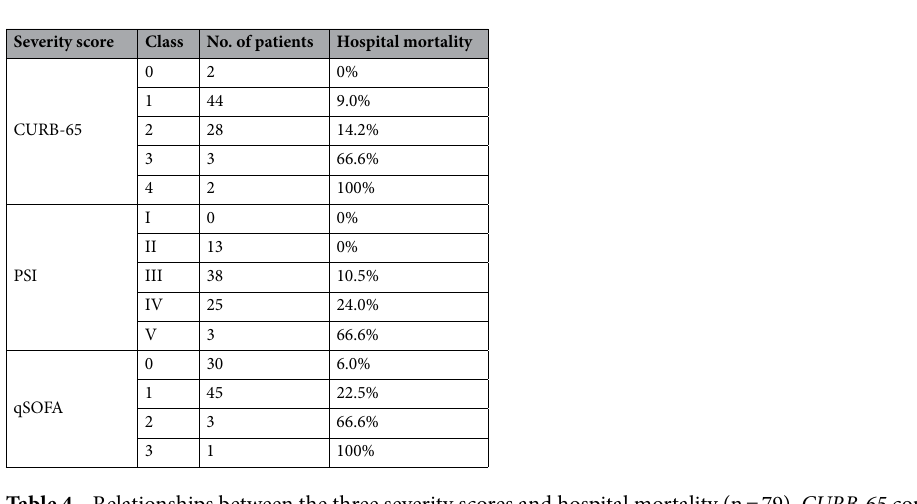
Table 4. Relationships between the three severity scores and hospital mortality (n = 79). CURB-65 confusion, urea, respiratory rate; blood pressure and age; PSI Pneumonia Severity Index; qSOFA quick Sequential Organ Failure